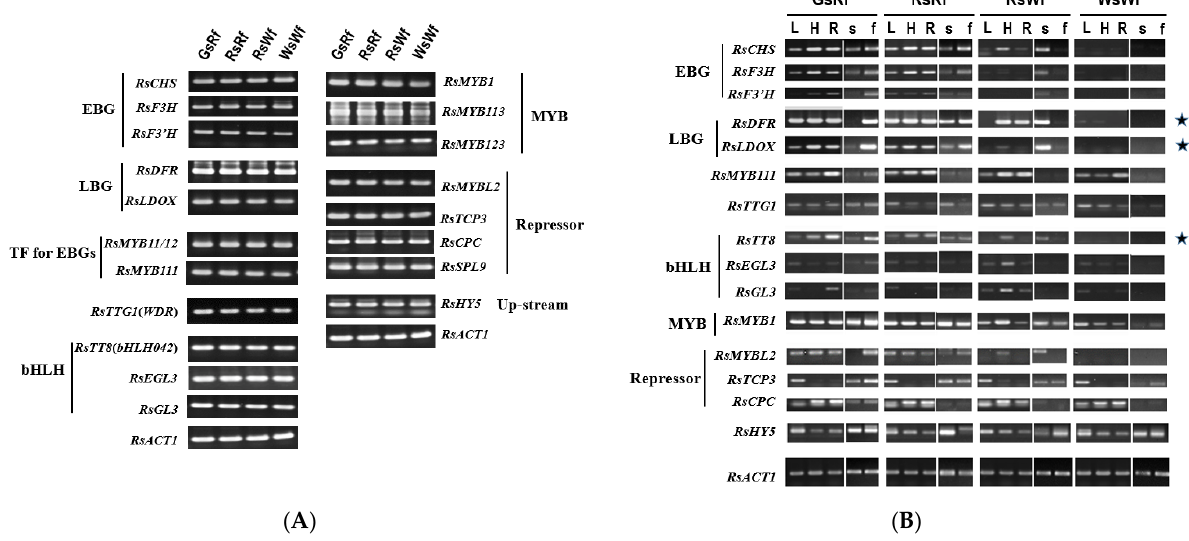
Figure 2. Presence ( A ) and expression ( B ) of genes related to anthocyanin accumulation in four radishes. ( A ) All genes were amplified by genomic DNA PCR. ( B ) Expression levels of genes. L, leaves, H, hypocotyls, R, roots, s, skin, and f, flesh. Asterisks indicated that expression levels were tightly related to anthocyanin accumulation.